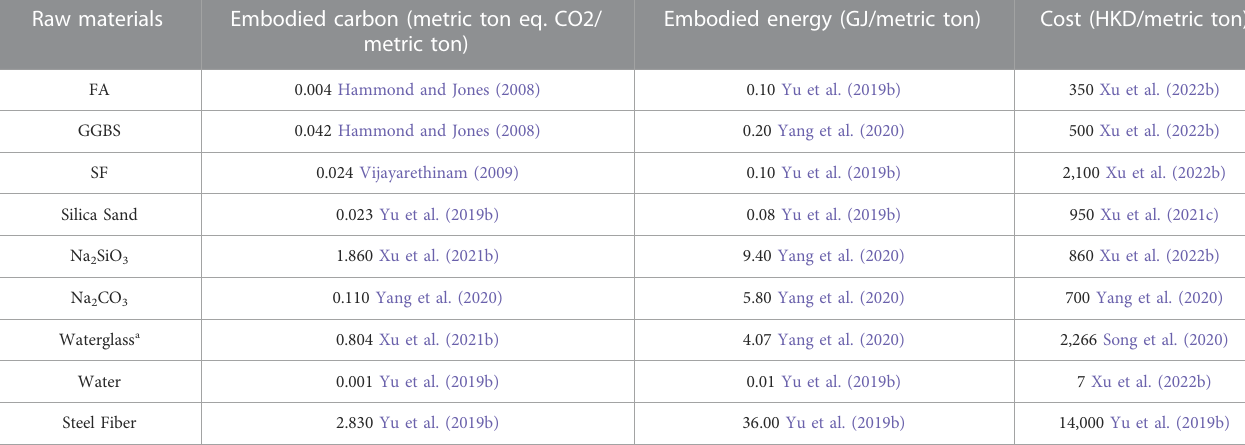
TABLE 2 Embodied carbon, embodied energy, and cost of raw materials.